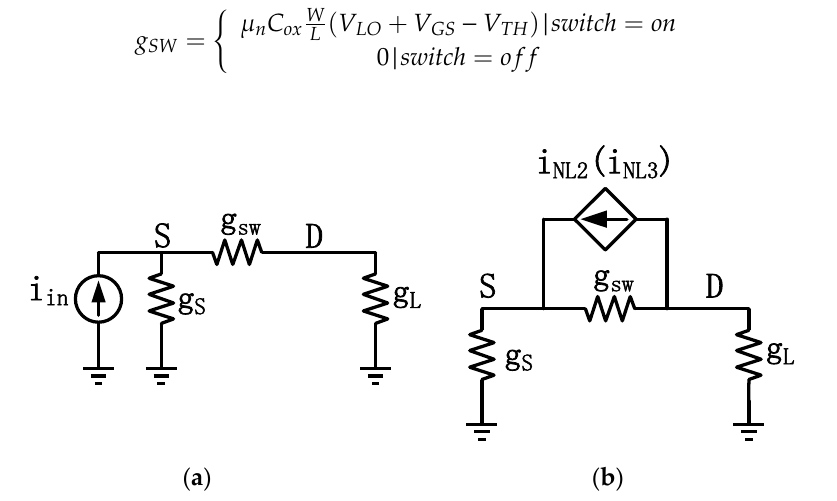
Figure 9. ( a ) Equivalent circuit of the proposed mixer; and ( b ) the nonlinearity source.